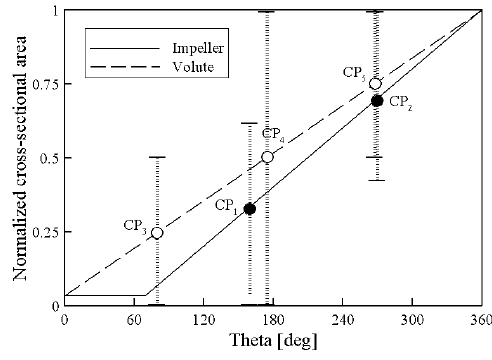
Figure 5. Defined design variables.